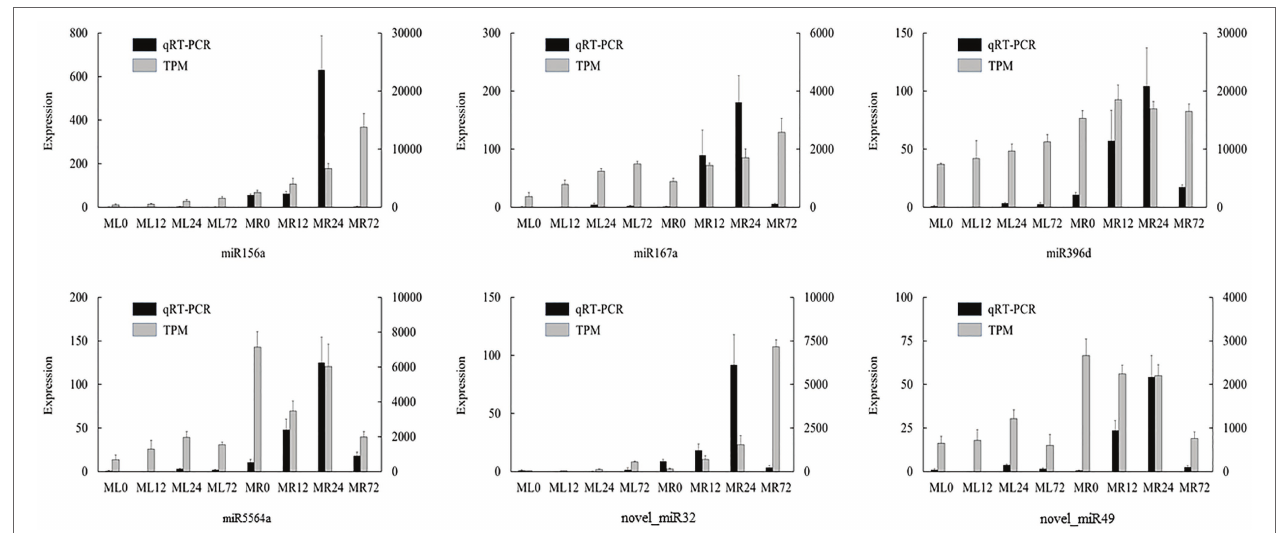
FIGURE 5 | Quantitative real time PCR (qRT-PCR) validation of differentially expressed miRNAs detected by miRNA sequencing. Vertical bars indicate mean values ± SD from three biological